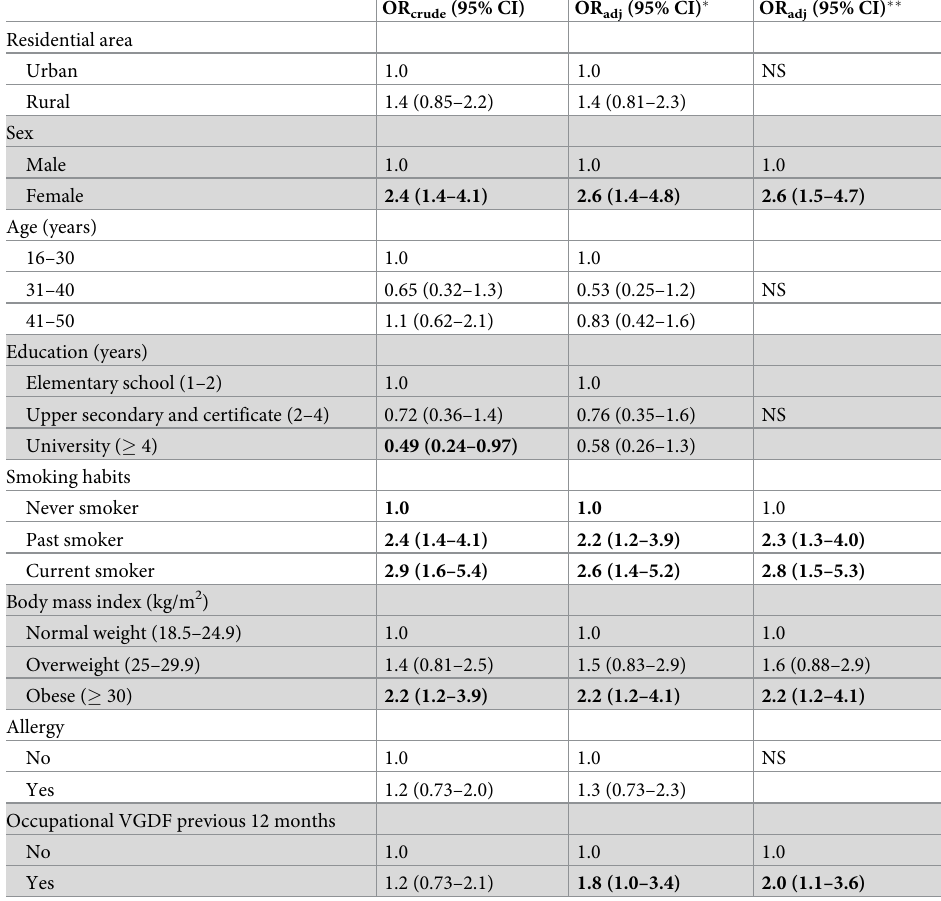
Table 2. Logistic regression-estimated odds ratios for risk factors associated with poorly controlled asthma (n =